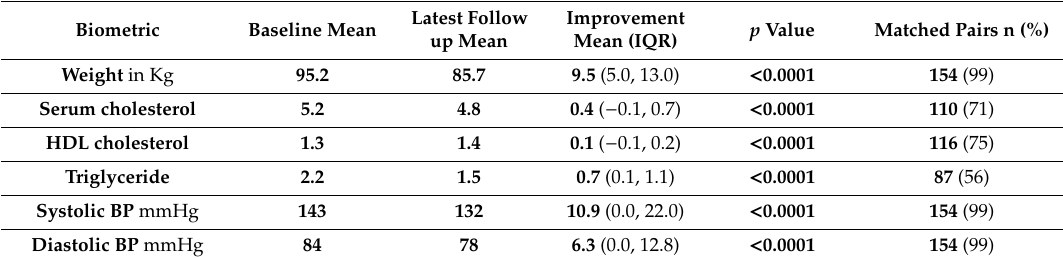
Table 1. Biometrics before and after an average of 24 months on a low carbohydrate diet.